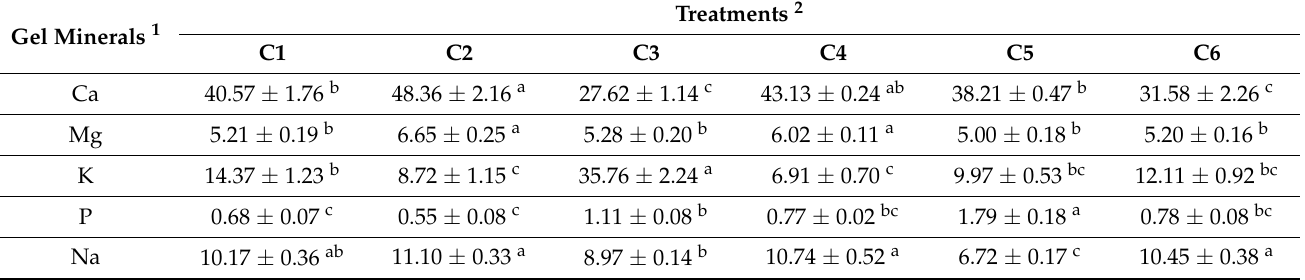
Table 5. The effects of fertilizer and microbial inoculants on mineral composition in the Aloe vera inner leaf